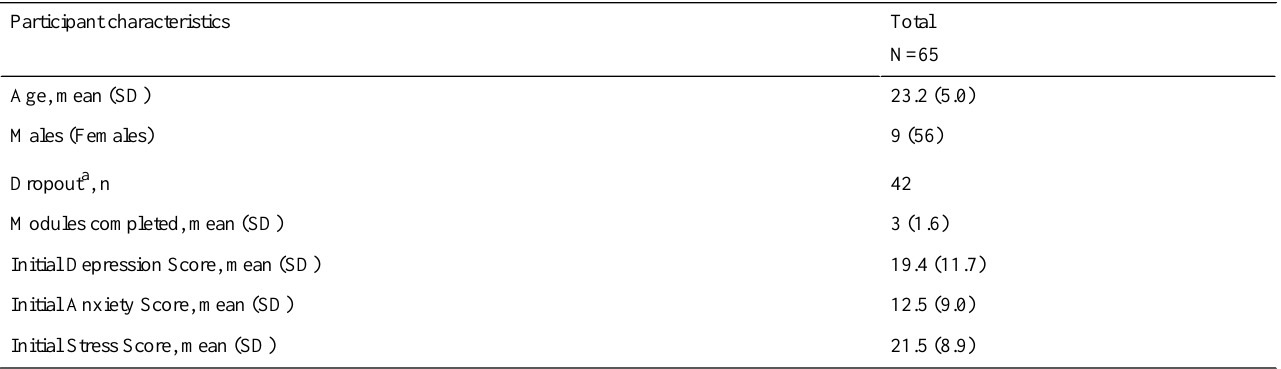
Table 2. Description of participant characteristics.